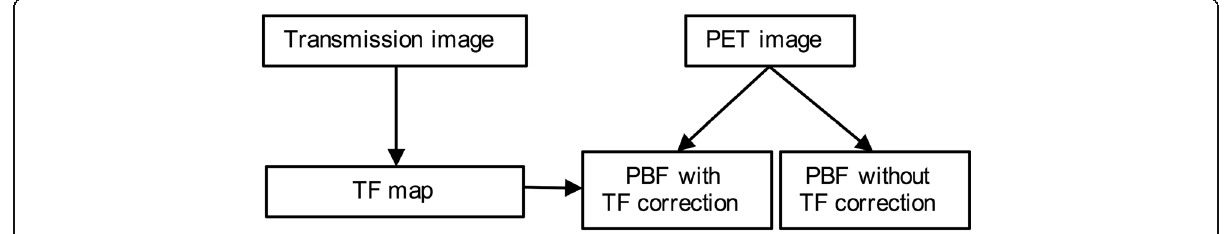
Fig. 1 Flow chart of the